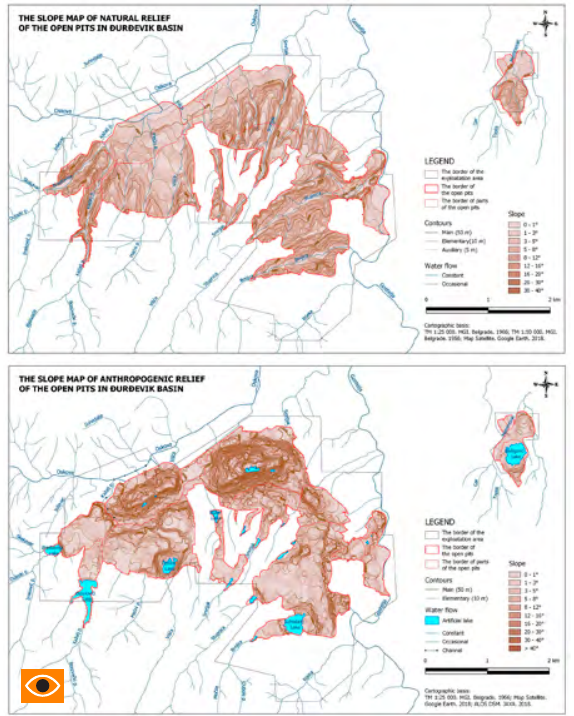
Figure 4. The slope map of natural (up) and anthropogenic (down) relief of the study